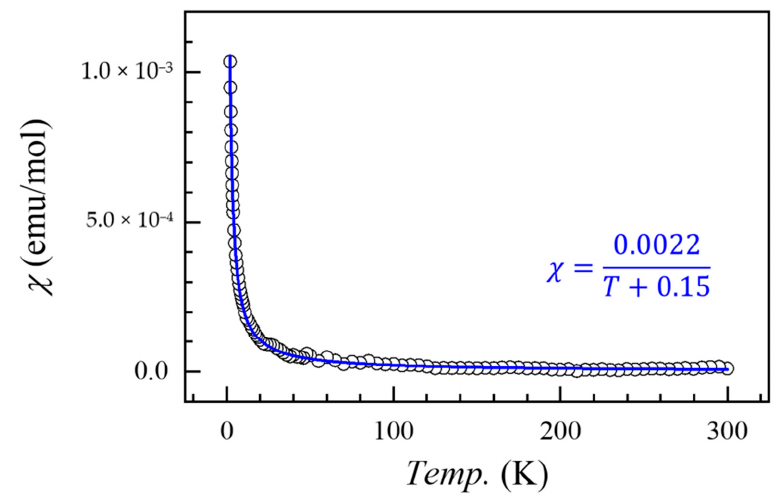
Figure 4. Temperature dependence of magnetic susceptibility of 2 at the field of 5000 Oe. The blue line is the Curie–Weiss fitting curve as described in the text.